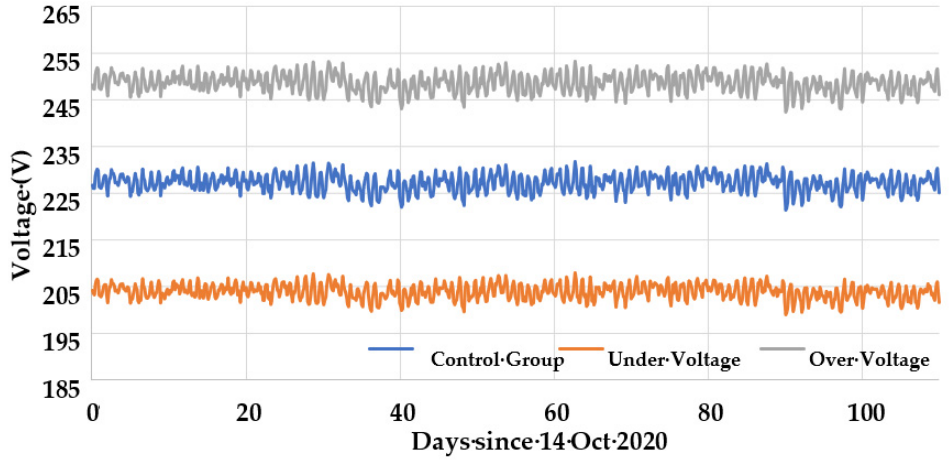
results of the voltage to which the lamps were exposed were the same as the results of measurements with the distribution transformer. The measurements in Figure 3 also show that the voltages in the three phases (groups) followed each other. Figure 3. Voltage with three of the groups, 3-h values, 14 October 2020 through 1 February 2021. The voltage will not be constant for a 3-h period. From the measurement data over each 3-h period, the highest rms value over a period of 20 ms and the rms value over the entire period were calculated. The difference between these two values is shown in Figure 4. The voltage varies less than 2% of the rated voltage over most 3-h periods. The highest measured variation is 3.1% of the rated voltage.